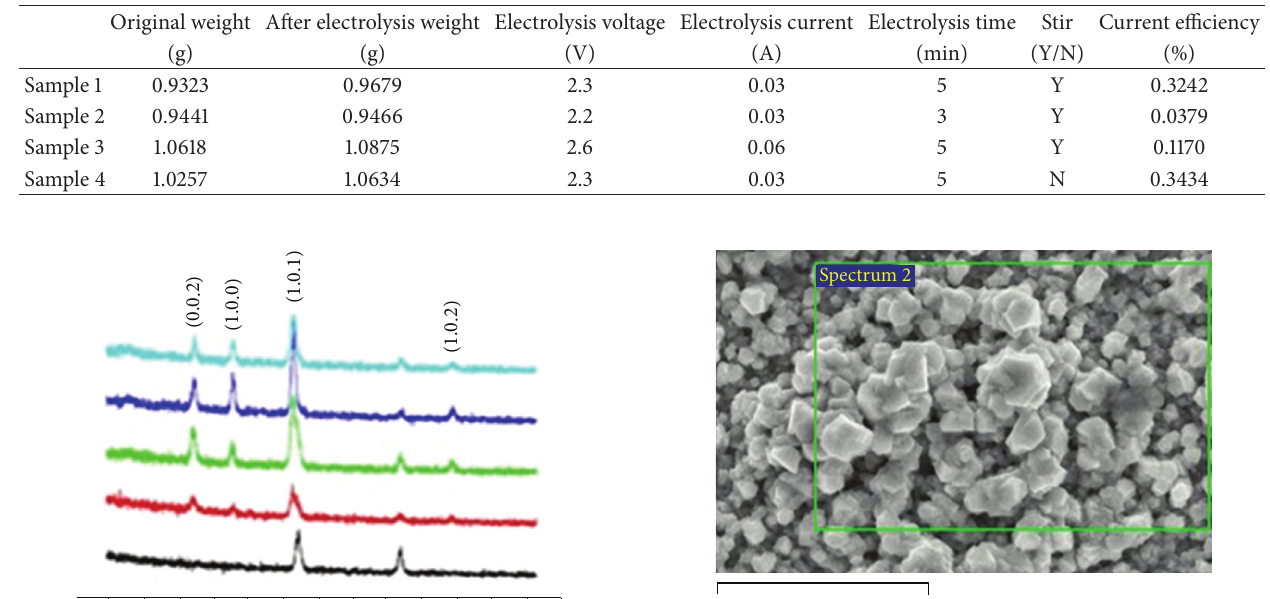
Table 3: The experimental parameters and data of constant current electrolysis.